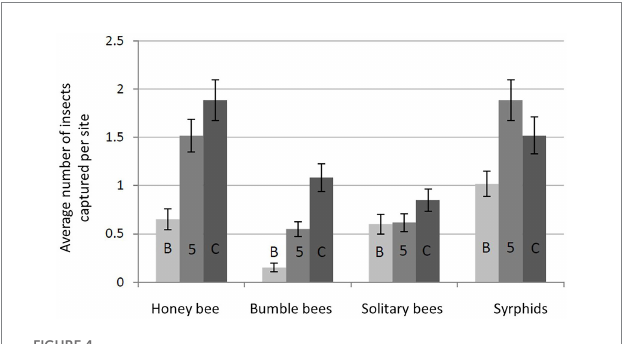
FIGURE 4 Average number of foraging bees according to position in the rapeseed plot. The bars represent the standard error. B: border, 5: at 5 m from the border, C: center of the field plot (method described in Le Féon,